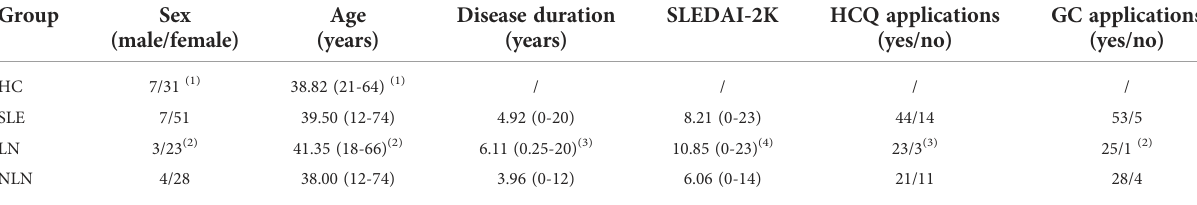
TABLE 1 General information characteristics of SLE patients and healthy controls.